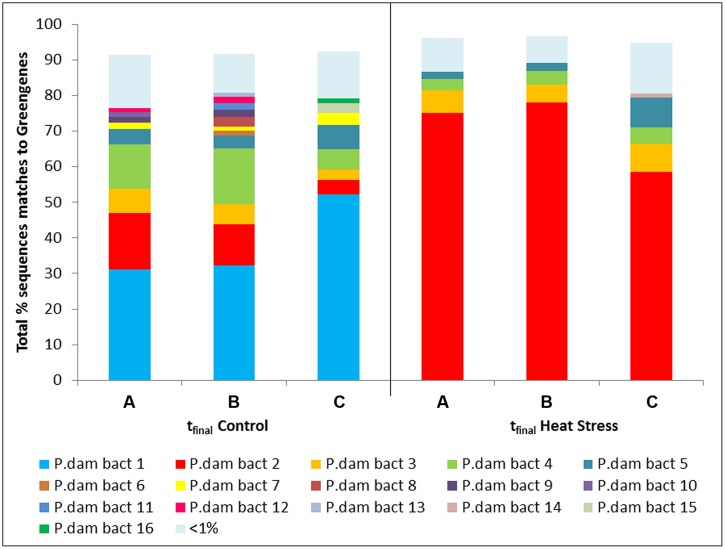
Operational taxonomic units (OTUs) from the Vibrio community associated with the coral P. damicornis on Heron Island, the Great Barrier Reef at tfinal Control (22°C; A–C are replicate nubbins) and tfinal Heat stress (31°C; A–C are replicate nubbins) conditions.